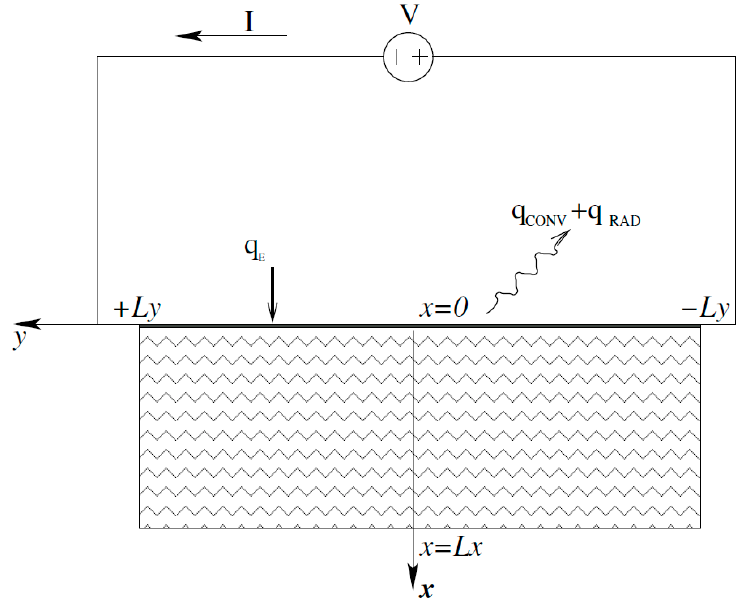
Figure 2. Thermal model of the panel. The z axis is not represented in the image.